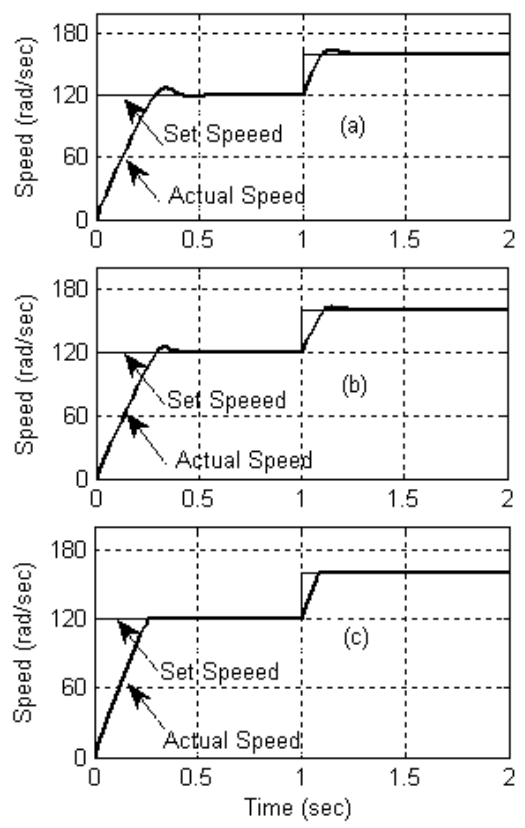
Fig. 8. Simulated response for a step chance in set speed from 120 rad/sec to 160 rad/sec (a) PI controller (b) Fuzzy-PI controller (c) Proposed Wavelet-Fuzzy Controller.